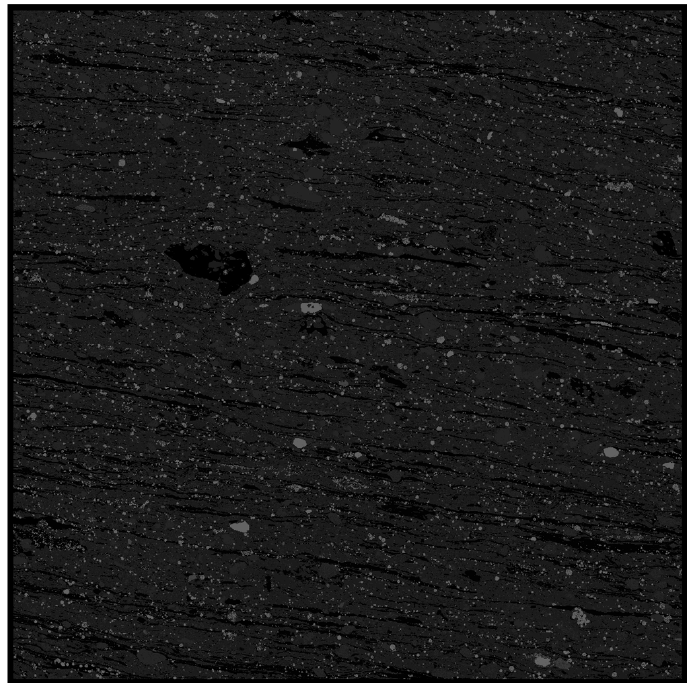
Figure 3. SEM diagram of mudstone.